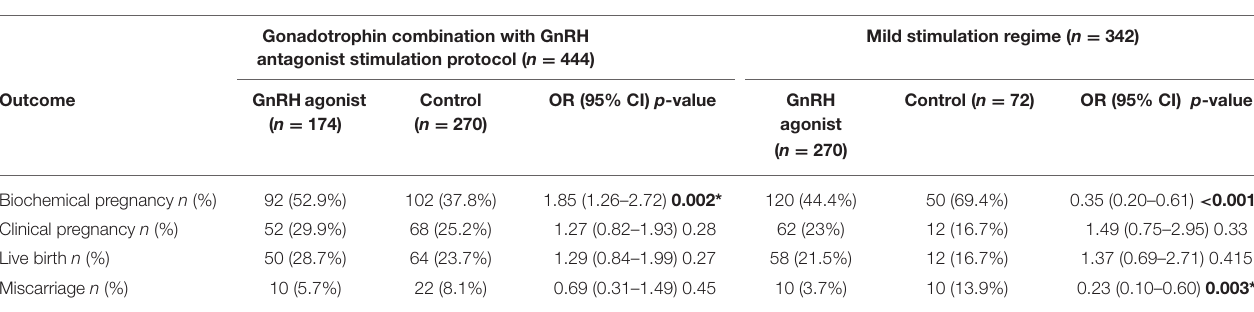
TABLE 5 | Different ovarian stimulation protocols and pregnancy